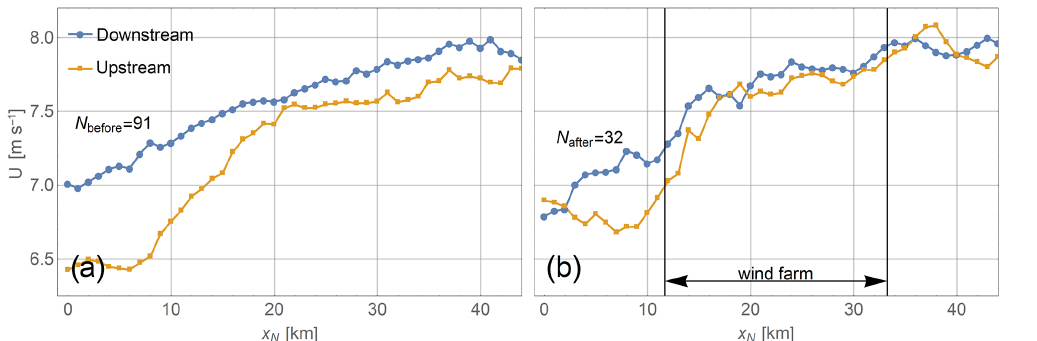
Figure 10. Wind speed transects similar to Fig. 8 from (a) before and (b) after construction for wind directions between 255 and 285 ◦ . Transect West is upstream and East is downstream of the (potential) wind farm location.